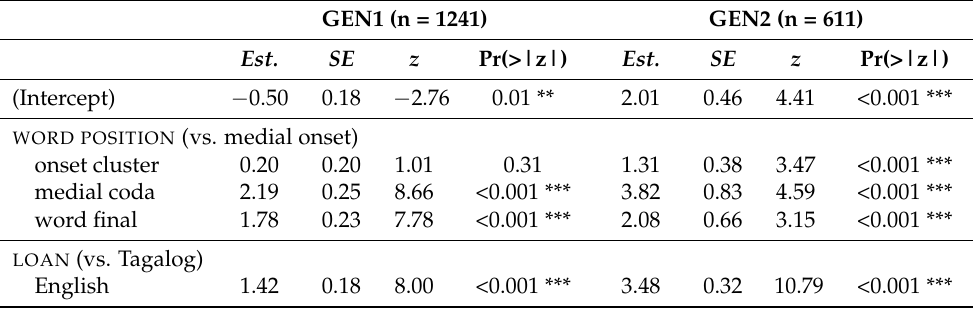
Table A2. Post-hoc analysis for GEN1 vs. GEN2 comparison, evaluating the effect of WORD POSITION and LOAN for GEN1 and GEN2 speakers separately. Significance codes: <0.001 ‘***’; <0.01